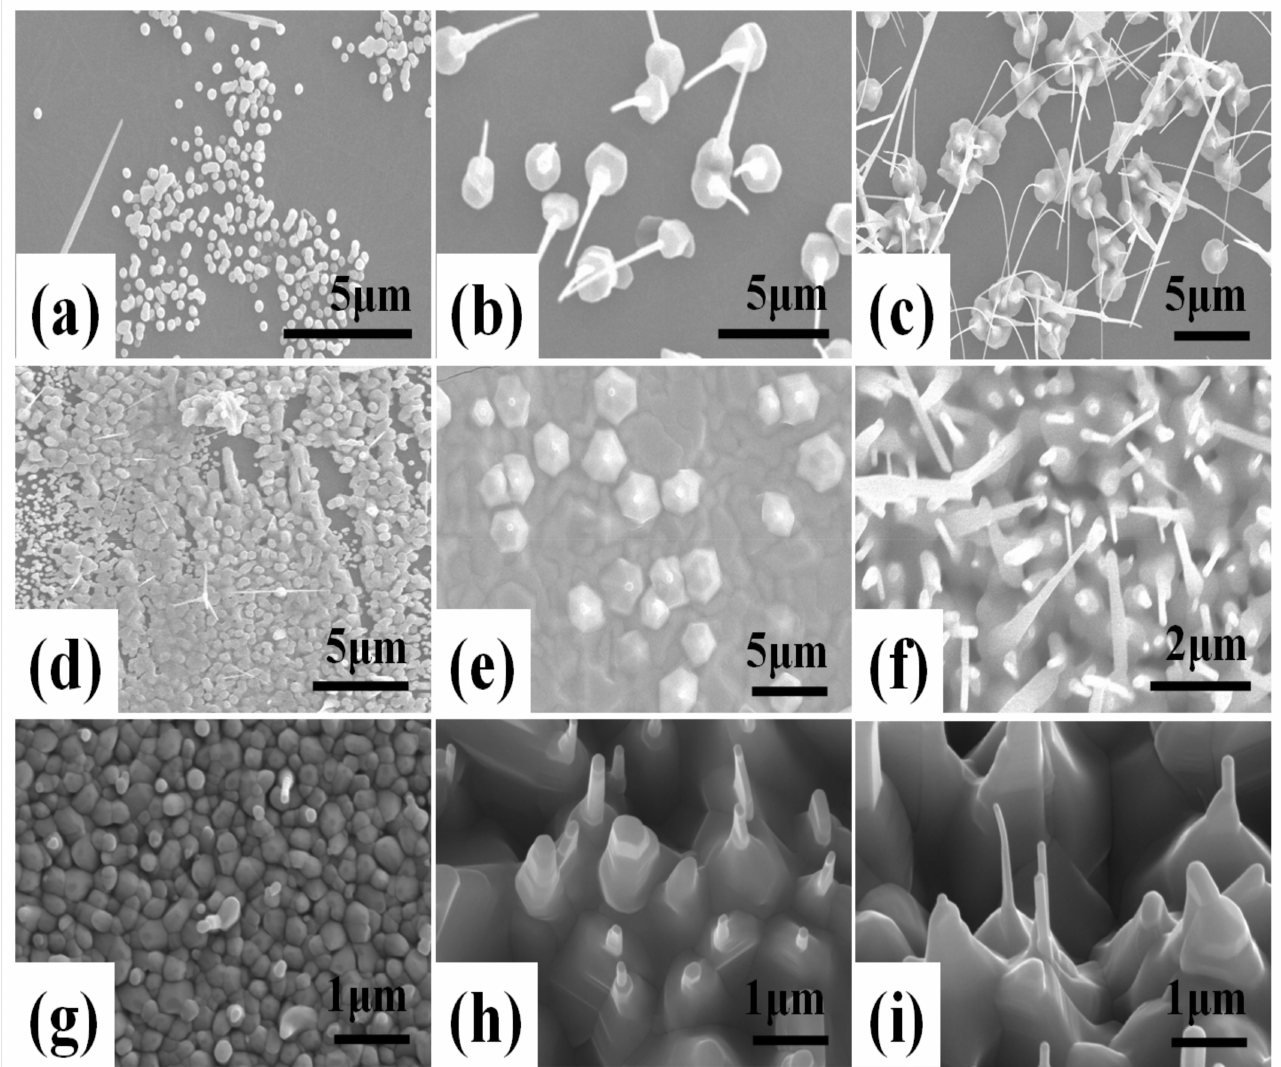
Figure 1. FE-SEM images of ZnO double-structured rods grown on ZnO-coated Si substrates by thermal CVD with perpendicular setup as functions of growth temperature and growth time: at 700 ◦ C for ( a ) 20 min, ( b ) 40 min, and ( c ) 60 min; at 800 ◦ C for ( d ) 20 min, ( e ) 40 min, and ( f ) 60 min; at 900 ◦ C for ( g ) 20 min, ( h ) 40 min, and ( i ) 60